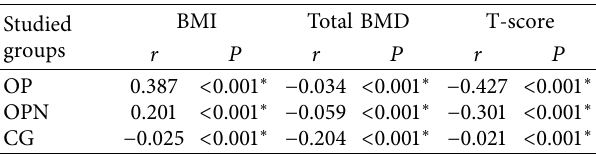
Table 3: The correlations of serum adiponectin ( μ g/ml) versus body mass index, BMD, and T-score in the studied